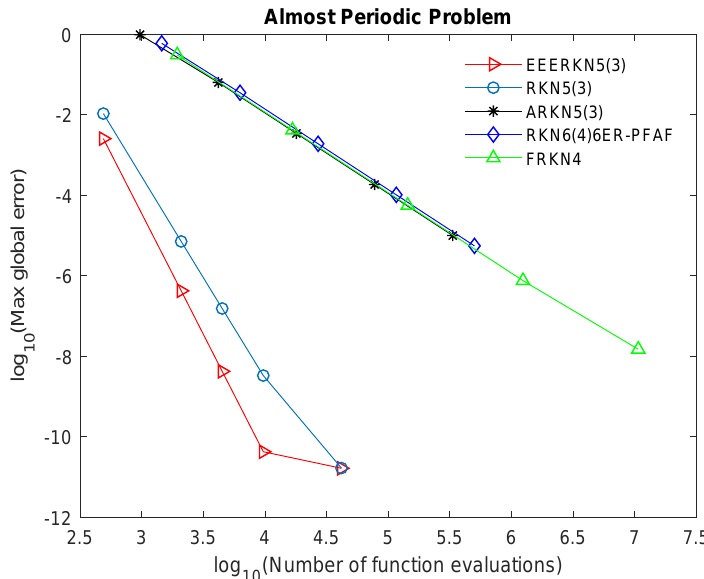
Figure 1. Efficiency curves for Problem